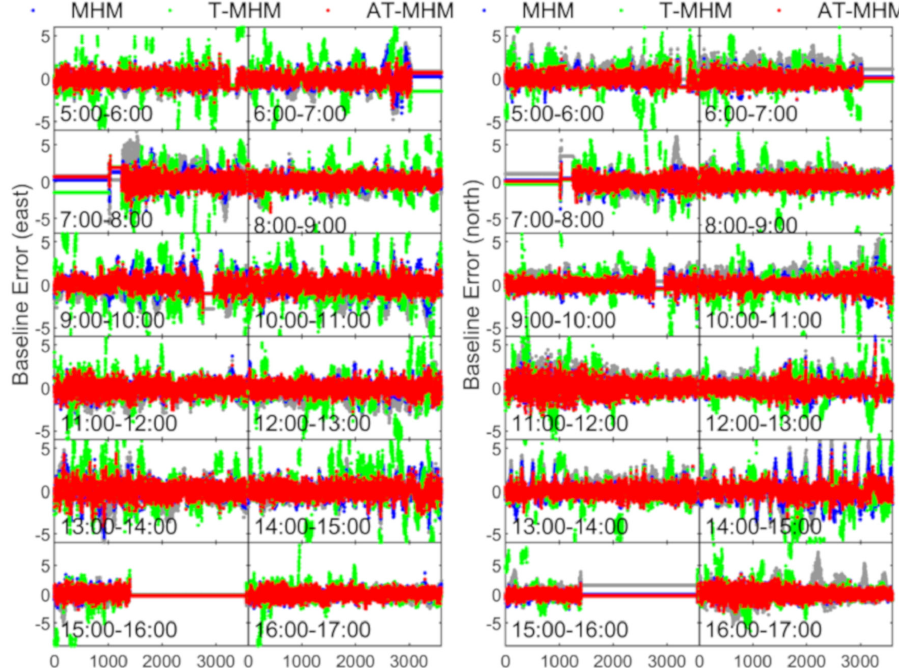
Figure 11. The results of the east ( left panel ) and north ( right panel ) directions before and after the multipath correction on DOY51. The color gray in the figure indicates the uncorrected baseline solution of DOY 51. X-axis unit: second, Y-axis unit: